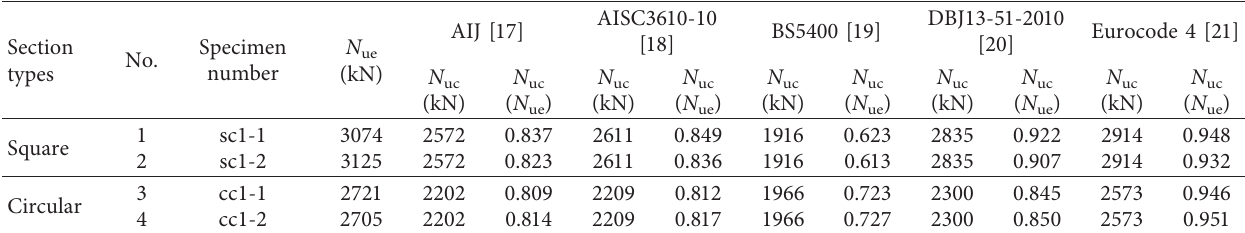
Table 2: Comparison between predicted capacities and test results for intact CFST column